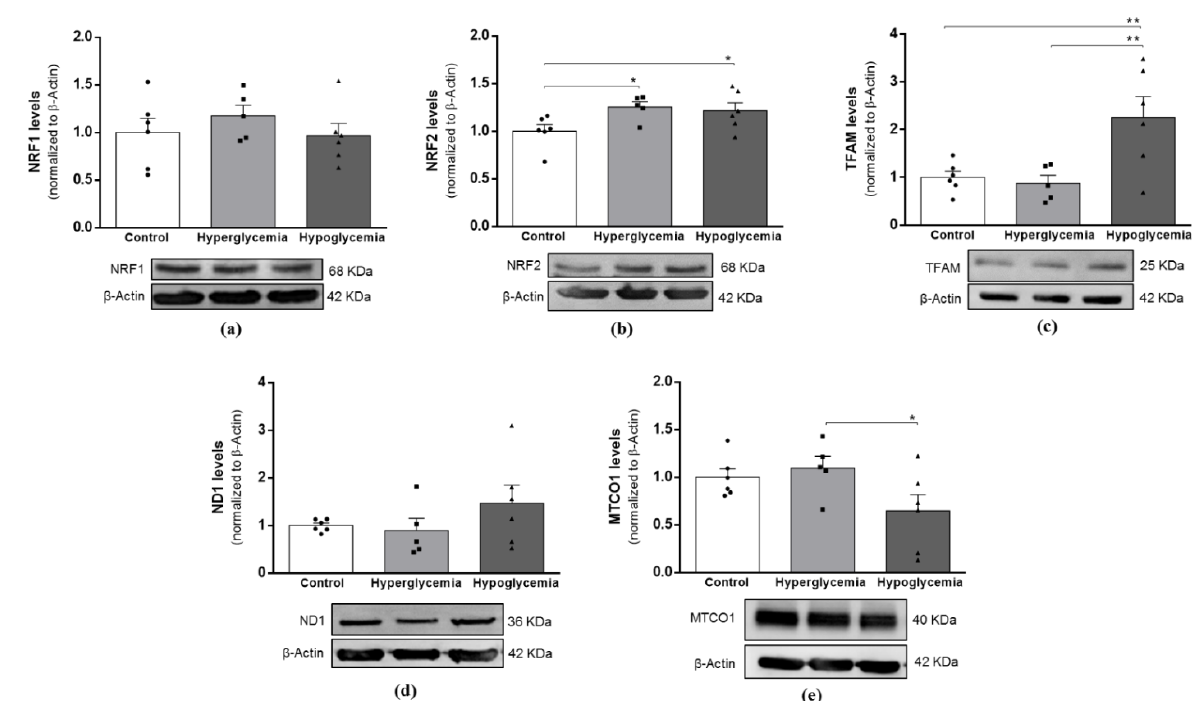
Figure 4. Effects of long-term hyperglycemia and insulin-induced recurrent hypoglycemia on mitochondrial biogenesis and protein levels of mitochondrial genes. Western blot analyses of ( a ) NRF1, ( b ) NRF2, ( c ) TFAM, ( d ) ND1 and ( e ) MTCO1 protein levels. Bars represent the mean ± SEM of the quantification of brain cortical samples from 5-6 rats under each condition after normalization with β-Actin levels with respect to control group. Representative immunoblots for each protein and the respective β-Actin results are shown below the graphs (for uncropped images of the Western blots, please see Supplementary data). ** p < 0.01 and * p < 0.05 were considered statistically significant differences.